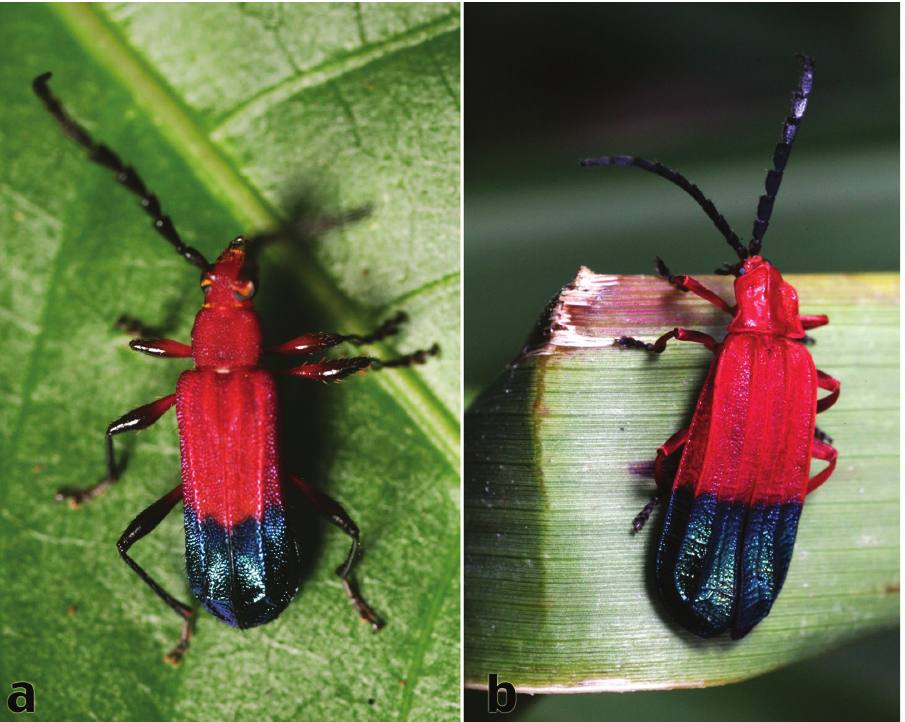
Figure 2. Members of the Batesian mimicry complex with Hispaniolan Hemilophini: a Trichrous termi- nalis (White) b Thonalmus sp. (Lycidae). Photos by Rick